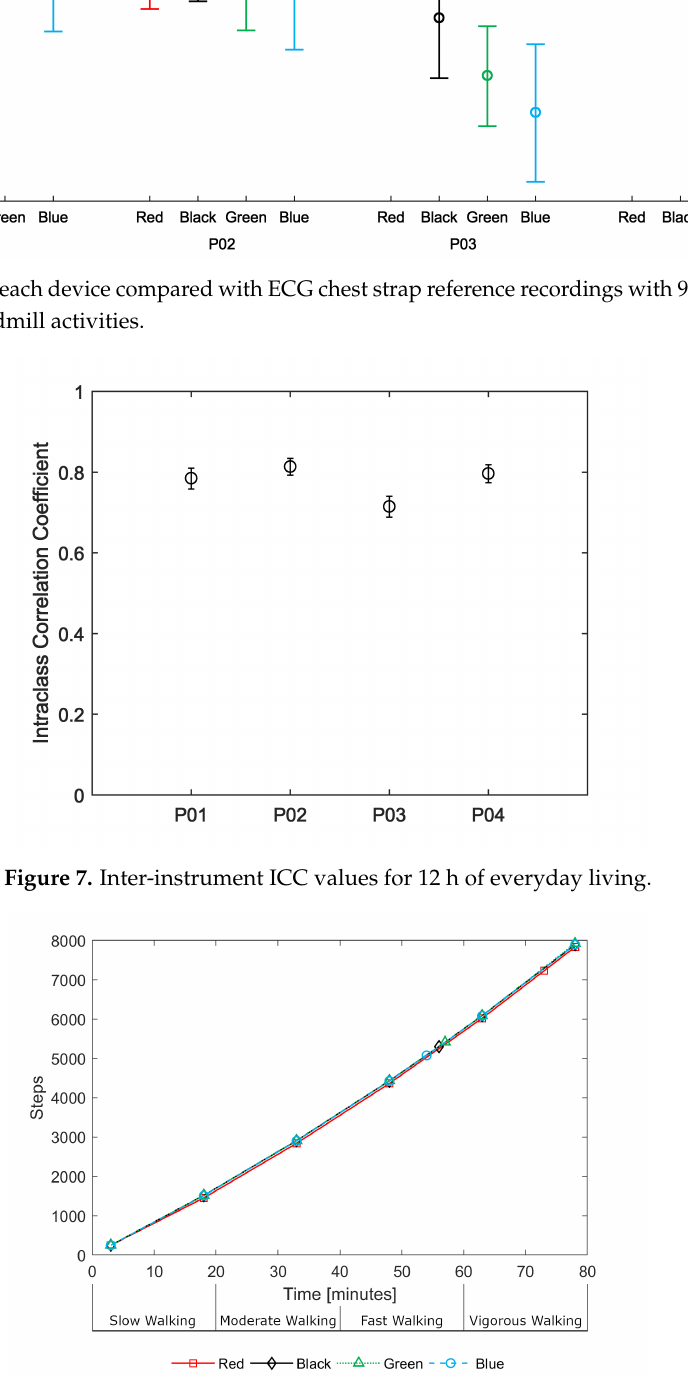
Figure 8. Example of ‘steps’ data (acquisition for participant P03 during treadmill